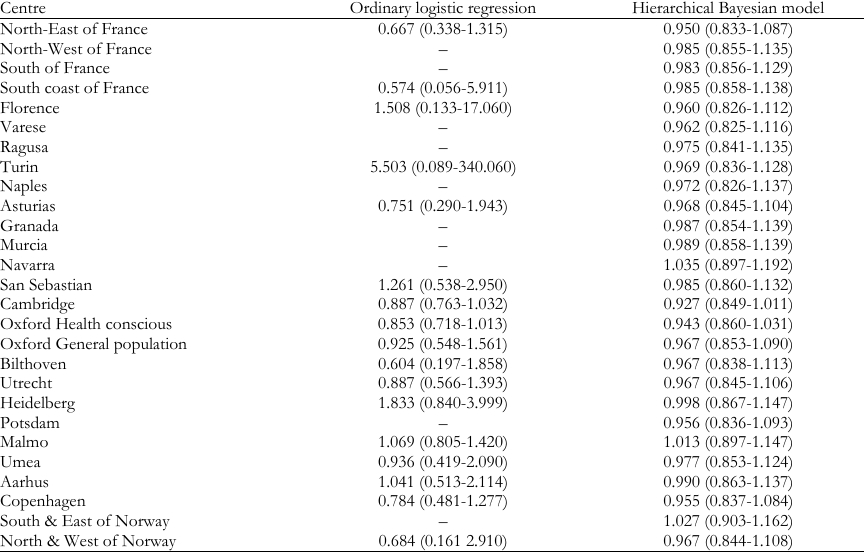
Estimated ORs (95% CI) by centre: cabbages